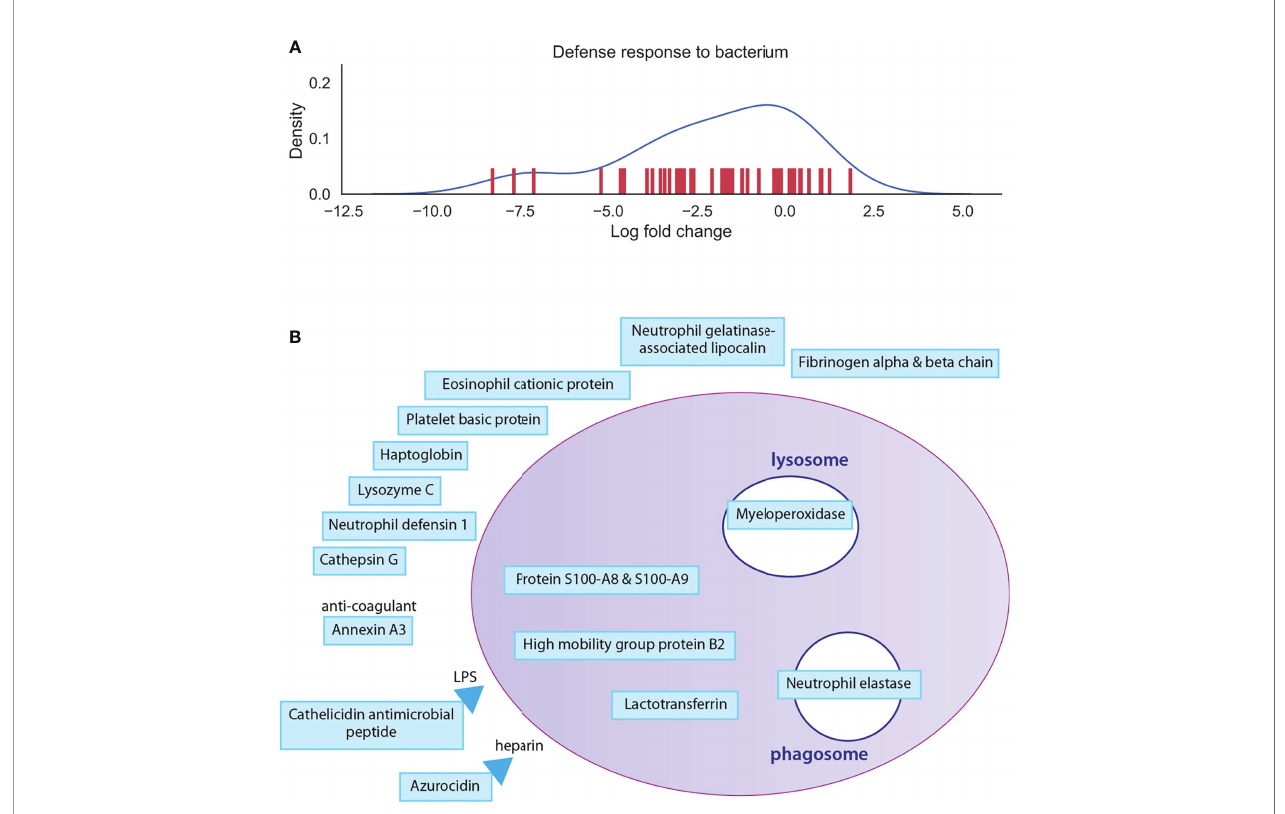
FIGURE 5 | Depiction of proteins signi fi cantly expressed in monocytes. (A) : The density curve and individual protein differential expression log2 values of protein expressions in the defense response to bacterium pathway identi fi ed in osteoclasts. (B) : drawing represents the most signi fi cantly expressed proteins involved in defense response to bacterium in monocyte samples compared to osteoclast samples. Blue fi lling shows downregulation of proteins in osteoclast samples compared to monocytes. The full table with p values are provided in Supplementary Table 4 .